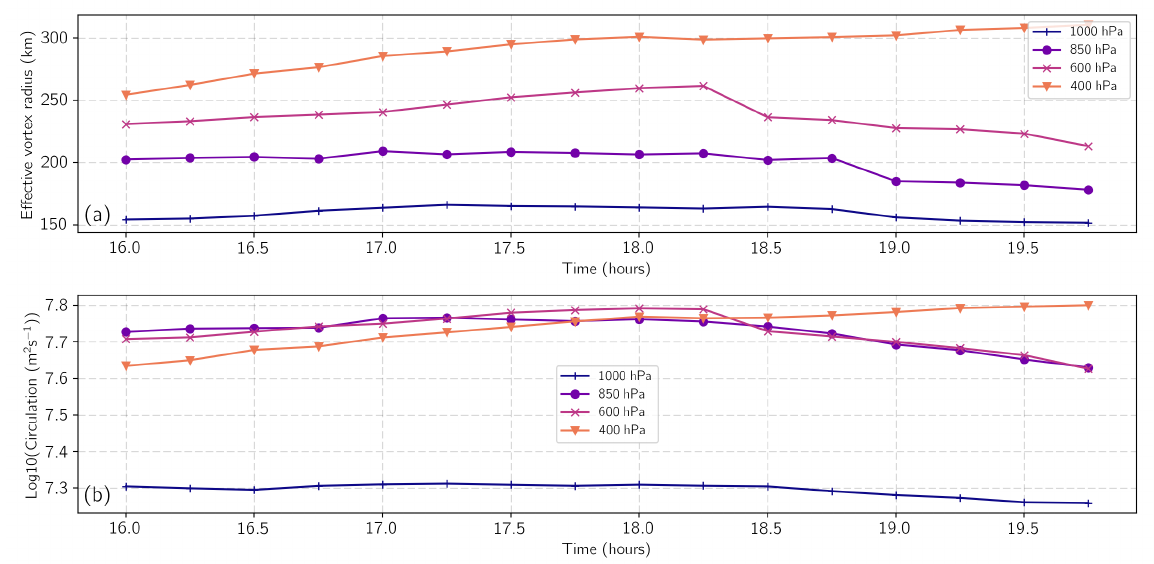
Figure 14. Temporal evolution of Kyrill’s vortex properties as seen in COSMO data for 18 January 2007 16:00UTC–19:45UTC (15-min time steps) at different pressure levels identified withhelp of the 2d W k -method with a threshold of 1.0: ( a ) effective radius (in km) and ( b ) logarithm of total circulation (in m 2 s − 1 ) derived by adding the positive circulations associated with Kyrill’s vortex